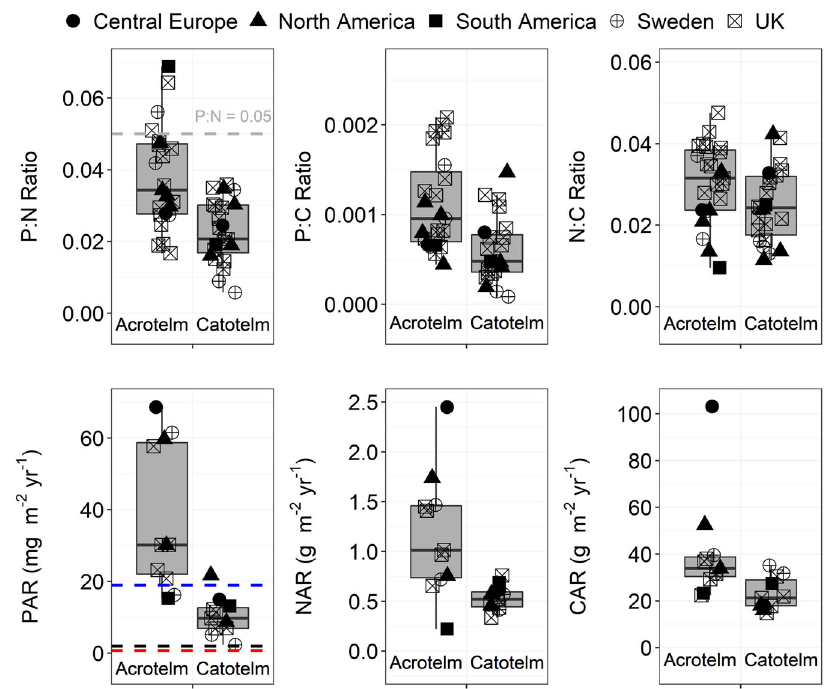
Fig. 2 Mean single-site stoichiometric ratios and accumulation rates measured in the acrotelm and catotelm at 23 mid-latitude peatlands. Horizontal offsets between points are solely for visualisation. Mean P:C, P:N and N:C stoichiometric ratios in catotelm peat are 0.0006, 0.023 and 0.024, respectively, and signi fi cantly lower than material in the acrotelm ( p < 0.05). Rates of phosphorus (PAR), nitrogen (NAR) and carbon (CAR) accumulation include values in the catotelm that represent true burial rates, whereas the acrotelm represent apparent rates. Depths of the acrotelm/catotelm boundary were taken from each publication or, where unreported, a depth of 40 cm was used after sensitivity testing 86,87 (see ‘ Methods ’ ). The horizontal dashed grey line on the P:N ratio plot denotes the critical stoichiometric threshold for P limitation (P:N = 0.05) in terrestrial ecosystems 59,60 . Horizontal black and red dashed lines on the PAR plot are modelled values of present-day and pre-industrial atmospheric deposition, respectively, from Brahney et al. 19 (see ‘ Methods ’ ). Modelled P constitutes only the long-range transport of fi ne mineral dust particles. The blue dashed line represents mean directly measured P deposition at nearby sampling stations reported in Tipping et al. 54 (see ‘ Methods ’ ). That acrotelm PAR exceeds monitored P deposition illustrates the effects of internal P recycling. More importantly for long-term peatland development, catotelm PAR is greater than the modelled long-distance mineral dust contribution. This holds true throughout the Holocene (Supplementary Fig. 3). This strongly suggests that bogs rely on local and regional nutrient input from nearby soils and ecosystems (see text for discussion), in line with recent fi ndings on mineral dust deposition in Swedish bogs 51